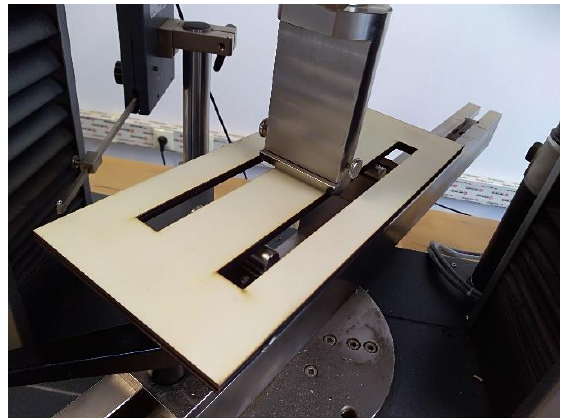
Figure 3. Framed rigid specimen during bending test.